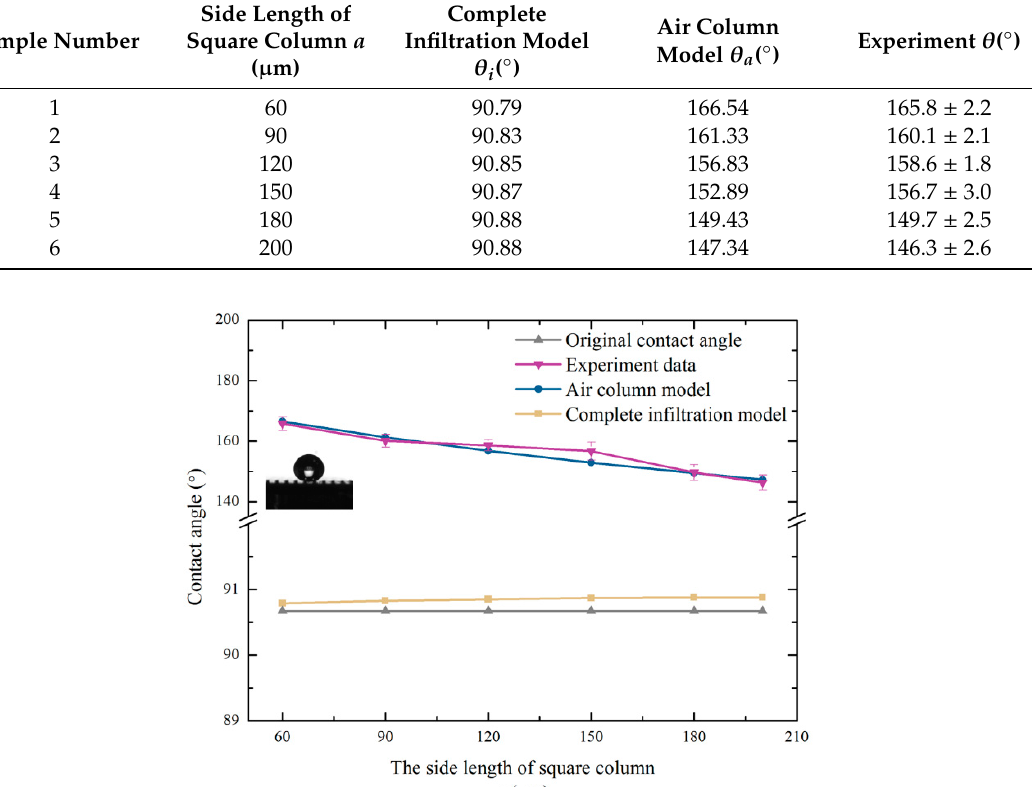
Figure 6. Surface diagram of the processed square column structure. Table 1. The theoretical and experimental values of contact angle.